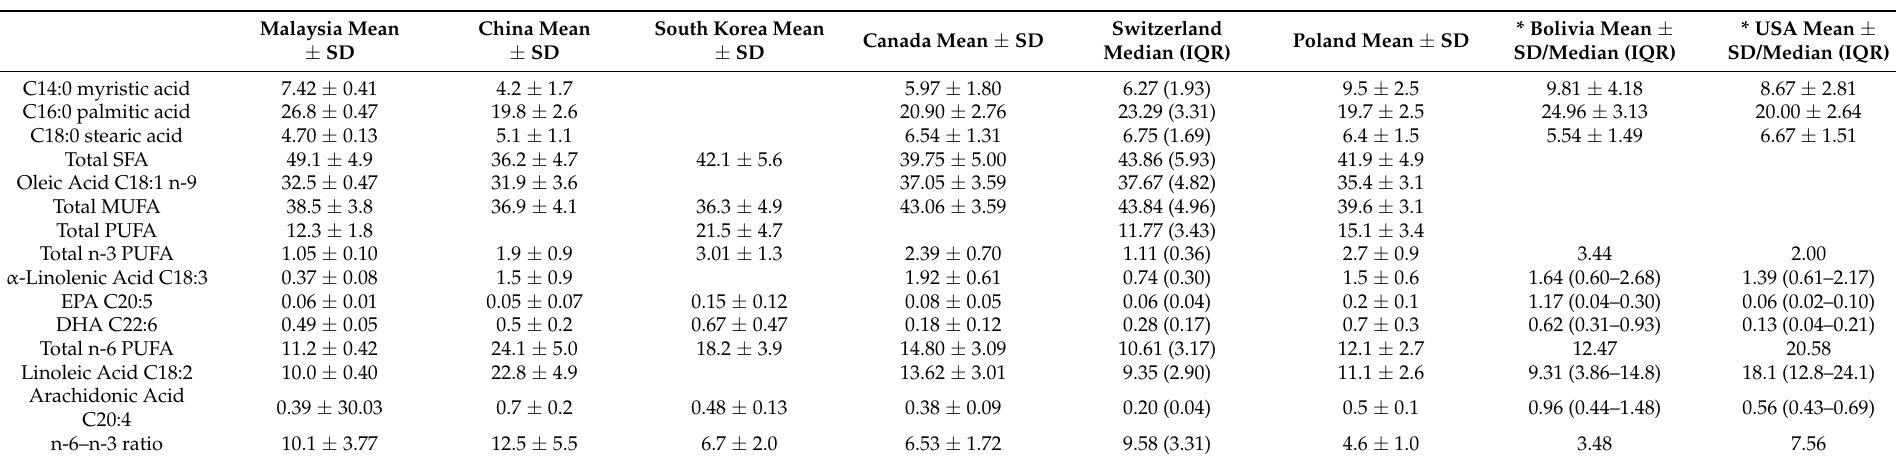
Table 3. Comparison of fatty acids contents (% of total fatty acids) in mature breast milk (>2 weeks and ≤ 16 weeks postpartum) from selected